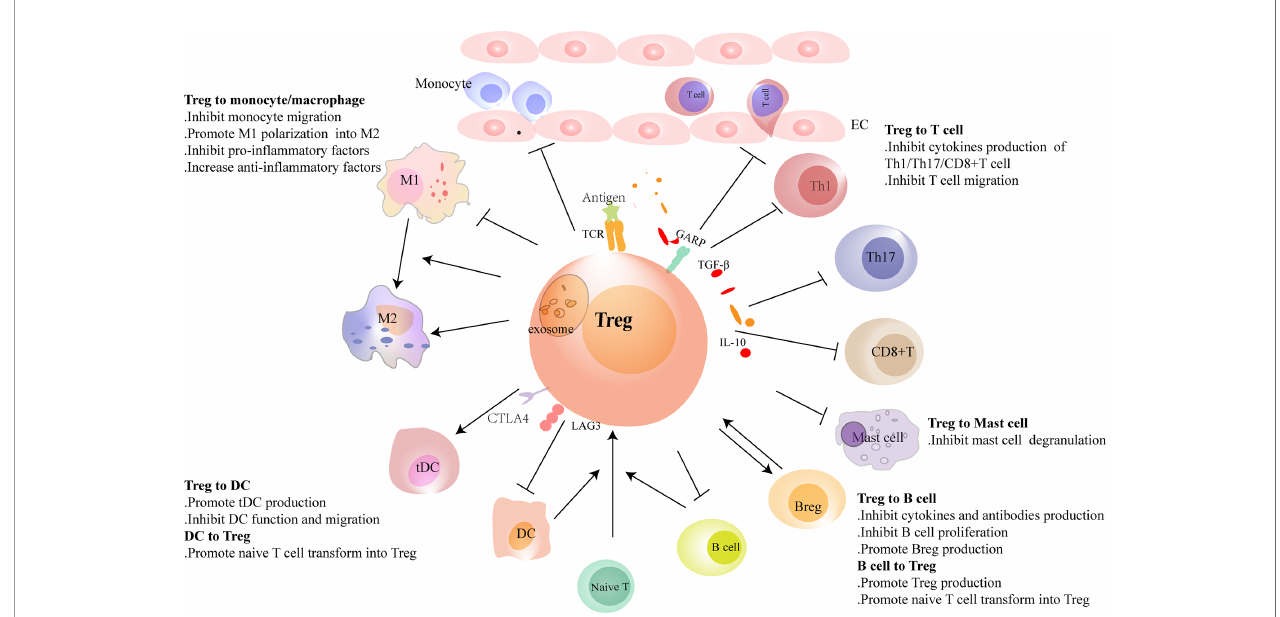
FIGURE 2 | Regulatory T cells (Tregs) interact with immune cells. Tregs regulate the recruitment and functions of immune cells through cell-to-cell contact or cytokine or exosome secretion. Tregs reduce the migration of monocytes from the circulation and promote the polarization of monocytes/M1 macrophages to M2 macrophages. Conventional dendritic cells (cDCs) induce naive T cells to differentiate into Tregs in physiological homeostasis. However, in heart injury, Tregs assist in the generation of tolerance DC (tDCs), and tDCs induce Treg proliferation in turn. Tregs inhibit the migration of T cells and regulate the function of Th1, Th17, and CD8 + T cells and reduce the production of pro-in fl ammatory factors and antibodies in B cells. Tregs promote the proliferation of regulatory B cells (Bregs). B cells, including Bregs, promote Treg proliferation. In heart failure, the balance of Th1/Th2 and Th17/Treg shifts to Th1 and Th17, respectively. Tregs are dysfunctional in both number and function in heart failure. Their inhibitory functions in T cells and B cells are damaged.